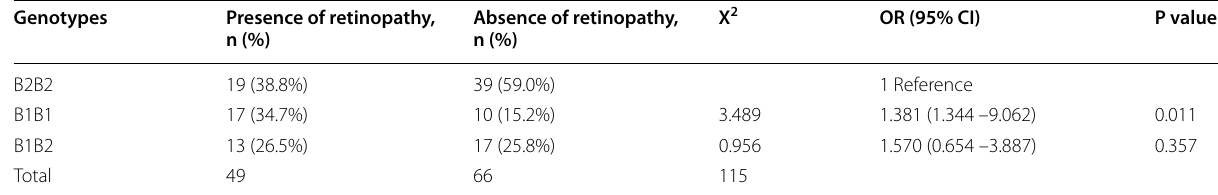
Table 3 Distribution of interleukin-4 genotypes in Sudanese patients with type 2 diabetes mellitus and risk analysis of developing diabetic retinopathy